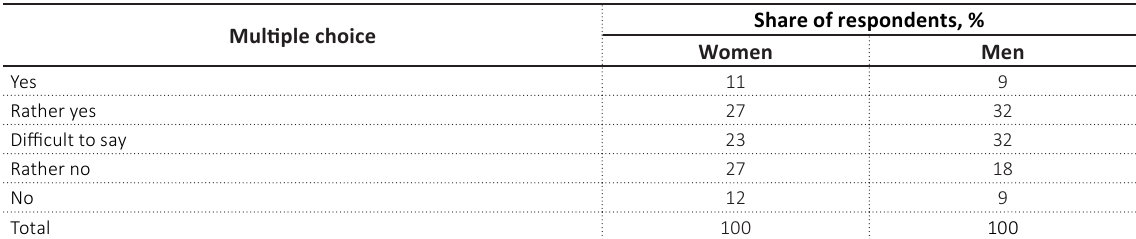
Table 7. Respondents’ answers to the question “Do you think your achievements are adequately